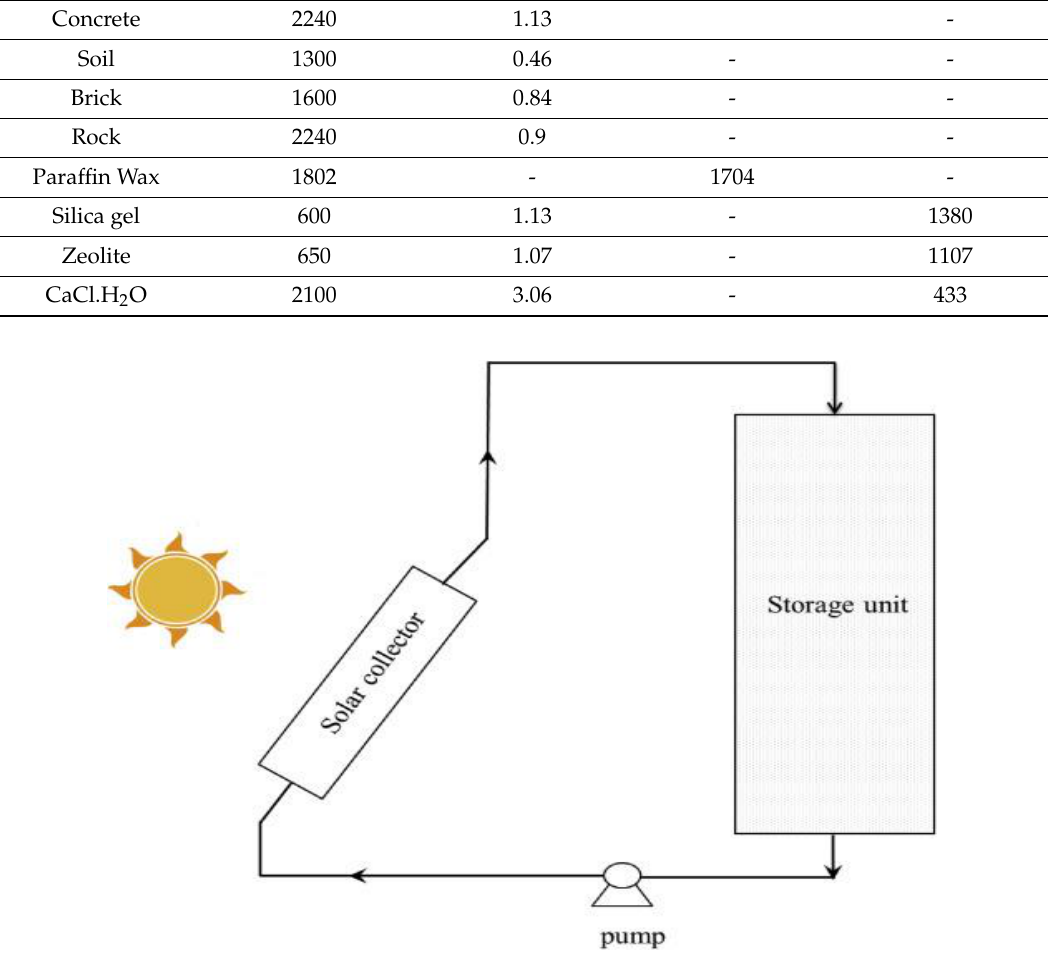
Figure 13. Solar thermal energy storage